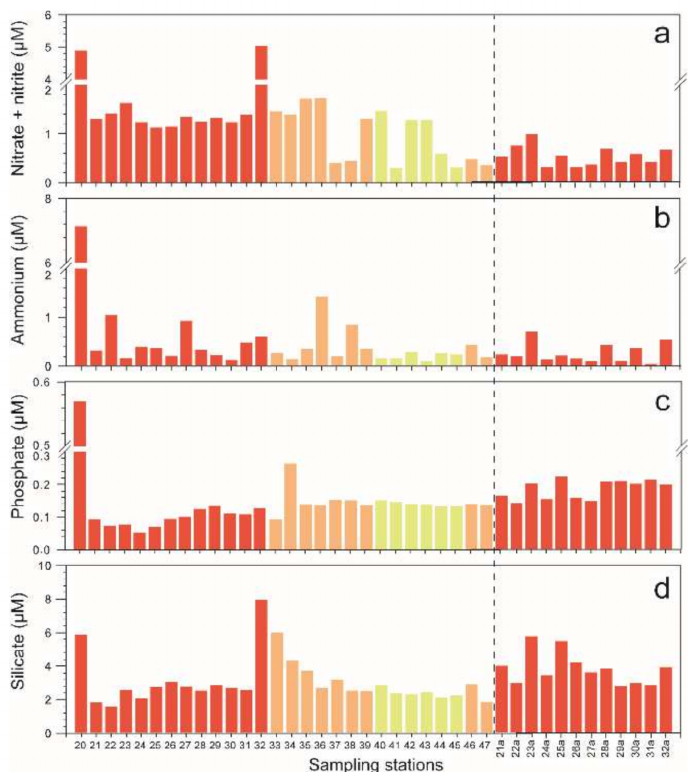
Figure 8. Horizontal distribution of nutrients at sampling stations in the East Sea during late spring (3 to 7 June). ( a ) nitrate + nitrite, ( b ) ammonium, ( c ) phosphate, and ( d ) silicate. Data after the dashed lines indicate resampled stations in the Uljin-Ulleung line (Stns. 21a to 31a). Bars are color coded as follows: red: UU, orange: UL, yellow: